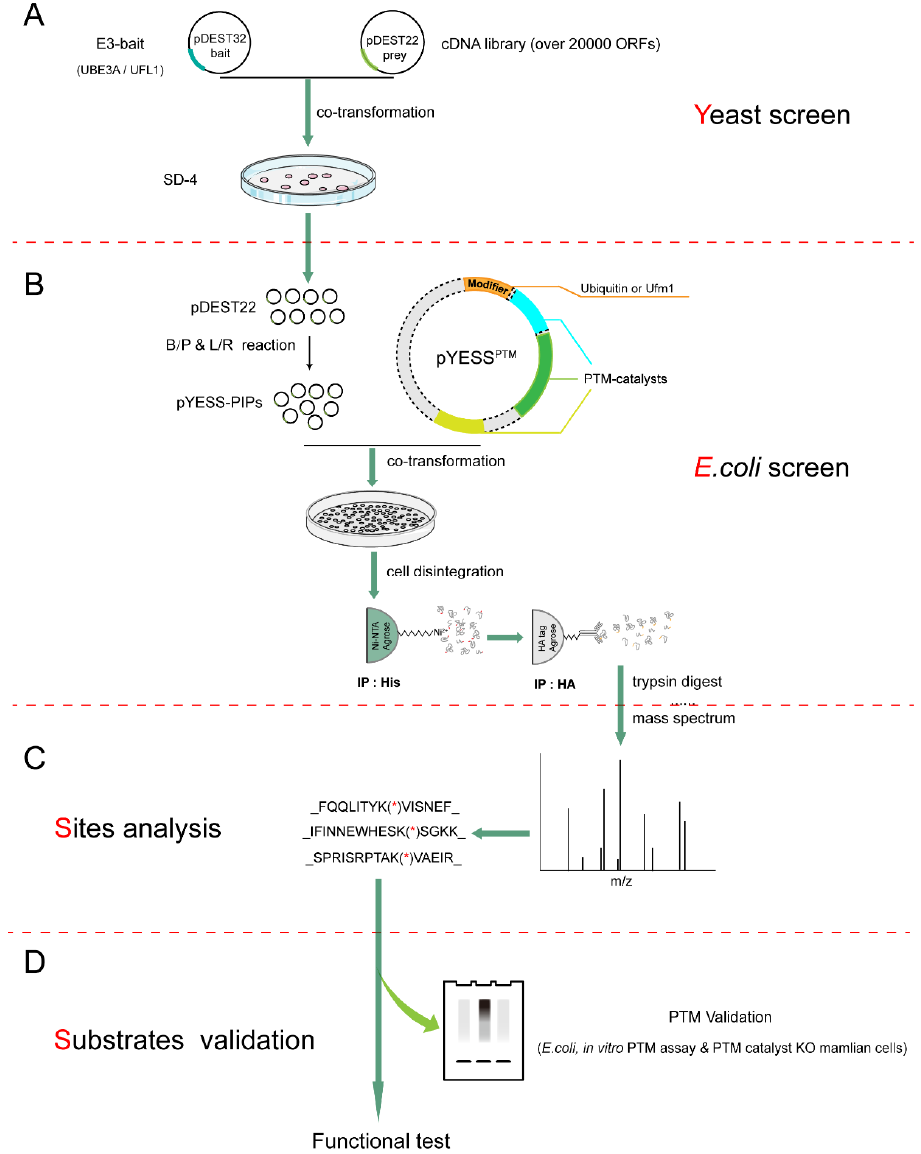
Figure 1. The workflow of YESS approach. Schematic illustration of the four major steps for YESS: ( A ) Y east two hybrid (Y2H) screening to identify interacting proteins of an E3 ligase (UBE3A/UFL1). ( B ) E . coli -based system to reconstitute ubiquitination/ufmylation followed by affinity enrichment of ( B ) E . coli -based system to reconstitute ubiquitination / ufmylation followed by a ffi nity enrichment